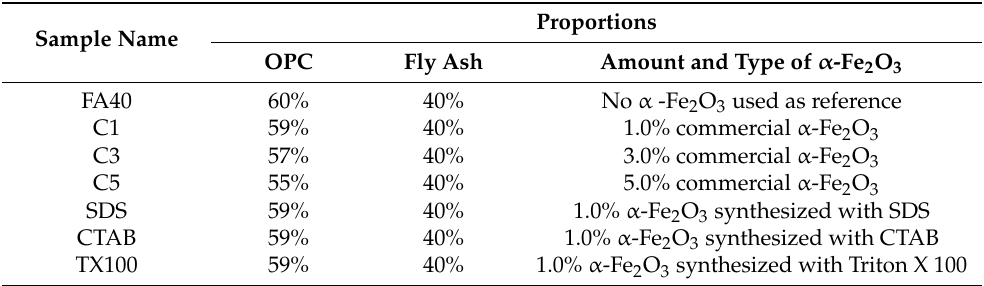
Table 1. The fraction of OPC, fly ash and α -Fe 2 O 3 nanoparticles as a binder and their